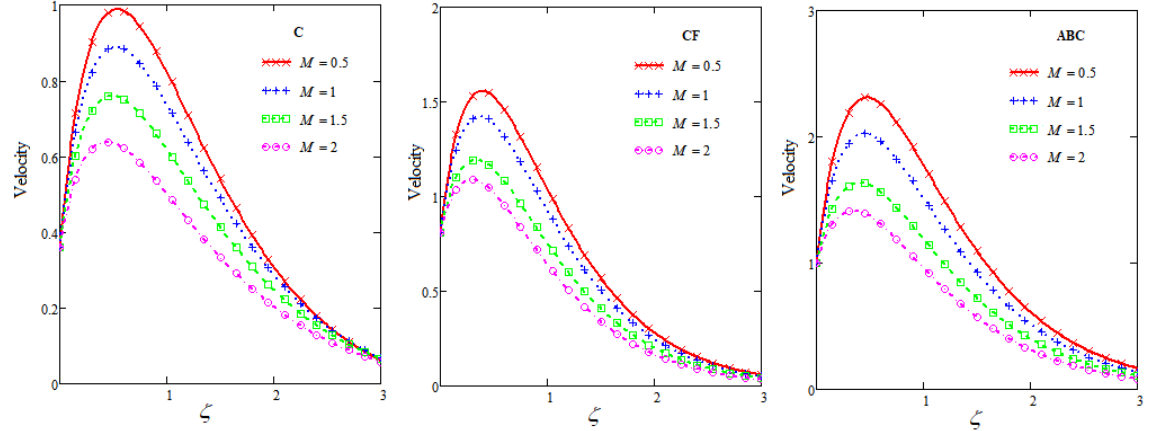
Figure 4. Velocity curves corresponding to C, CF and ABC with variable M where P r = 7, S c = 0.66, G r = 10, G m = 5, H = 3, R = 5, S r = 3, K r = 2, κ = 0.5, γ 1 = 0.1, h = 0.5, c = 1.05 and b = 0.75.